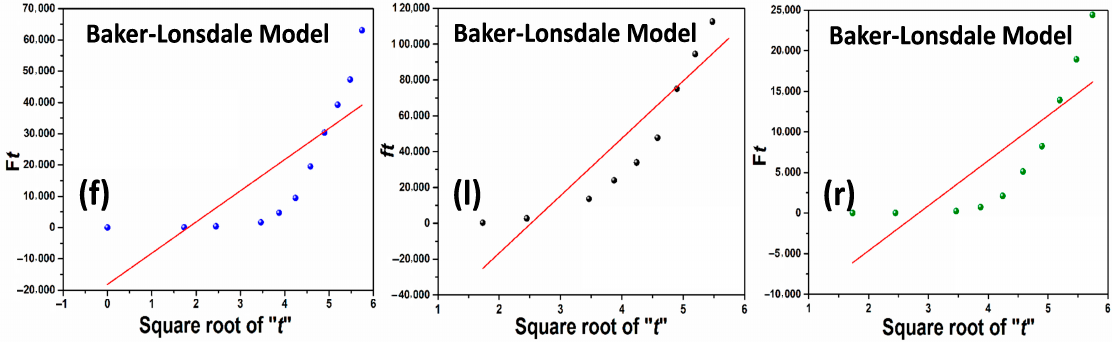
Figure 6. The hydrogel sample BSG-3 was taken to on a random basis to determine curcumin release kinetics at different pH levels (6.4 ( a – f ), 7.4 ( g – l ), and 8.4 ( m – r )) against different mathematical models (Zero order, First order, Higuchi, Korsmeyer-Peppas, Hixson & Bakers-Lonsdale).